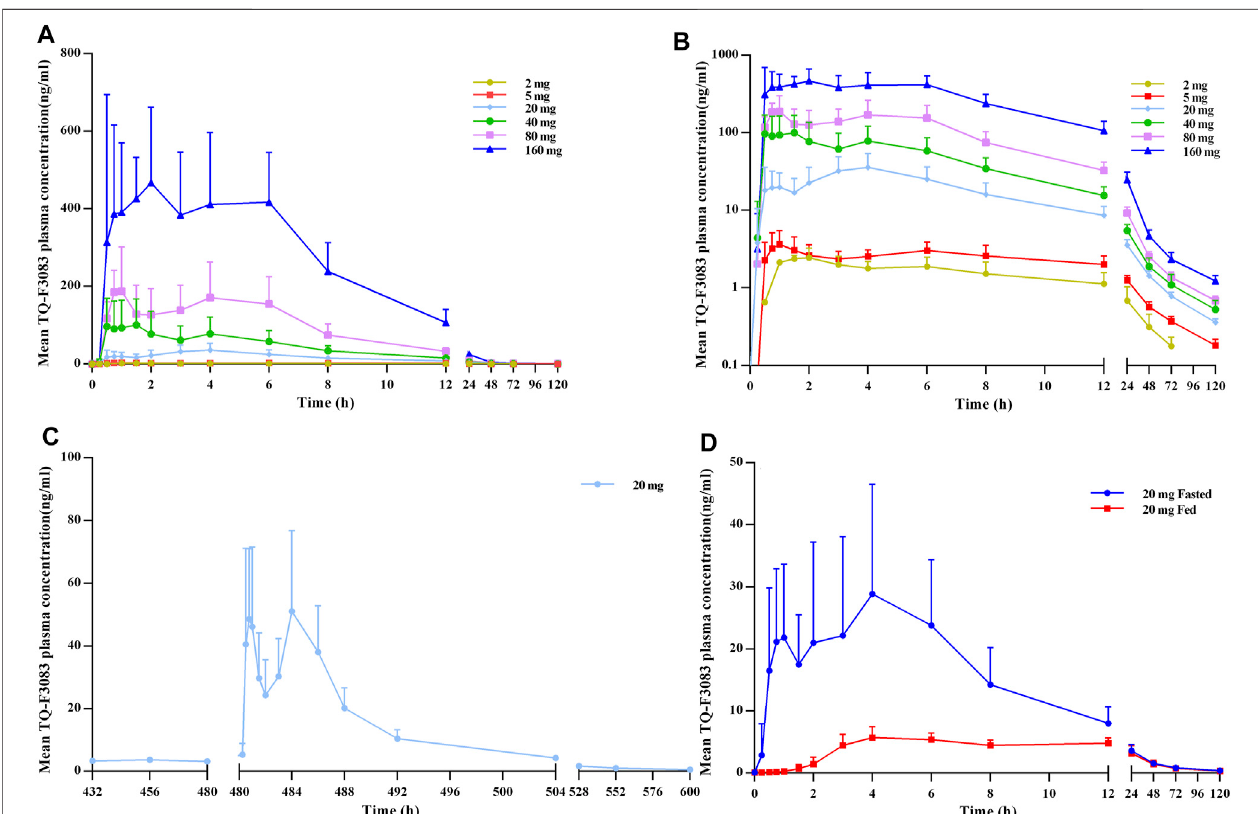
FIGURE 2 | TQ-F3083 mean (SD) plasma concentration – time pro fi les after administration of a single ascending dose from 2 to 160 mg. (A) , mean values after singledose. (B) ,pro fi lesplottedonasemi-logarithmicscale. (C) ,meanvaluesaftermultipledosesof20 mg. (D) ,meanvaluesaftersingledoseof20 mginthefastedand fed